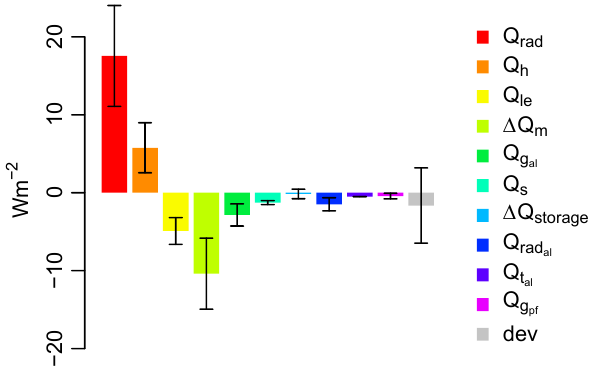
Figure 5. 5-year averages over all three seasons (with correspond- 5yr averages over all three seasons (with corresponding standard deviations) of the Fig. 5. ing standard deviations) of the energy balance components at the energy balance components at rock glacier Murt`el-Corvatsch. Q rad : Net radiation; Q h : Sensible Murtèl–Corvatsch rock glacier. Q rad : net radiation; Q h : sensible heat heat flux at the surface; Q le : Latent heat flux at the surface; ∆ Q m : Melt energy in the snow cover; flux at the surface; Q le : latent heat flux at the surface; ∆ Q m : melt en- Q s : Conductive heat flux through the snow; Q g : Conductive heat flux within the active layer; al ergy in the snow cover; Q s : conductive heat flux through the snow; Q rad : Net radiation in the active layer; ∆ Q storage : Change of heat content in the active layer; al Q g : conductive heat flux within the active layer; Q rad : net radia- Q t : Turbulent heat flux in the active layer; Q g : Conductive heat flux through the permafrost al al al pf tion in the active layer; ∆ Q storage : change in heat content in the active table; dev: Energy balance closure. layer; Q t : turbulent heat flux in the active layer; Q g : conductive Figure 6. Simulated and measured temperatures at the Murtèl– al pf Fig. 6. Simulated and measured temperatures at rock glacier Murt`el-Corvatsch showing the heat flux through the permafrost table; dev: energy balance closure. Corvatsch rock glacier showing the calibration without (simulated calibration without (simulated A) and with source/sink term (simulated B) at depths of 5.6 m A) and with thee source / sink term (simulated B) at depths of 5.6 and 11.5 m below the surface, within the permafrost layer. and 11.5m below the surface, within the permafrost